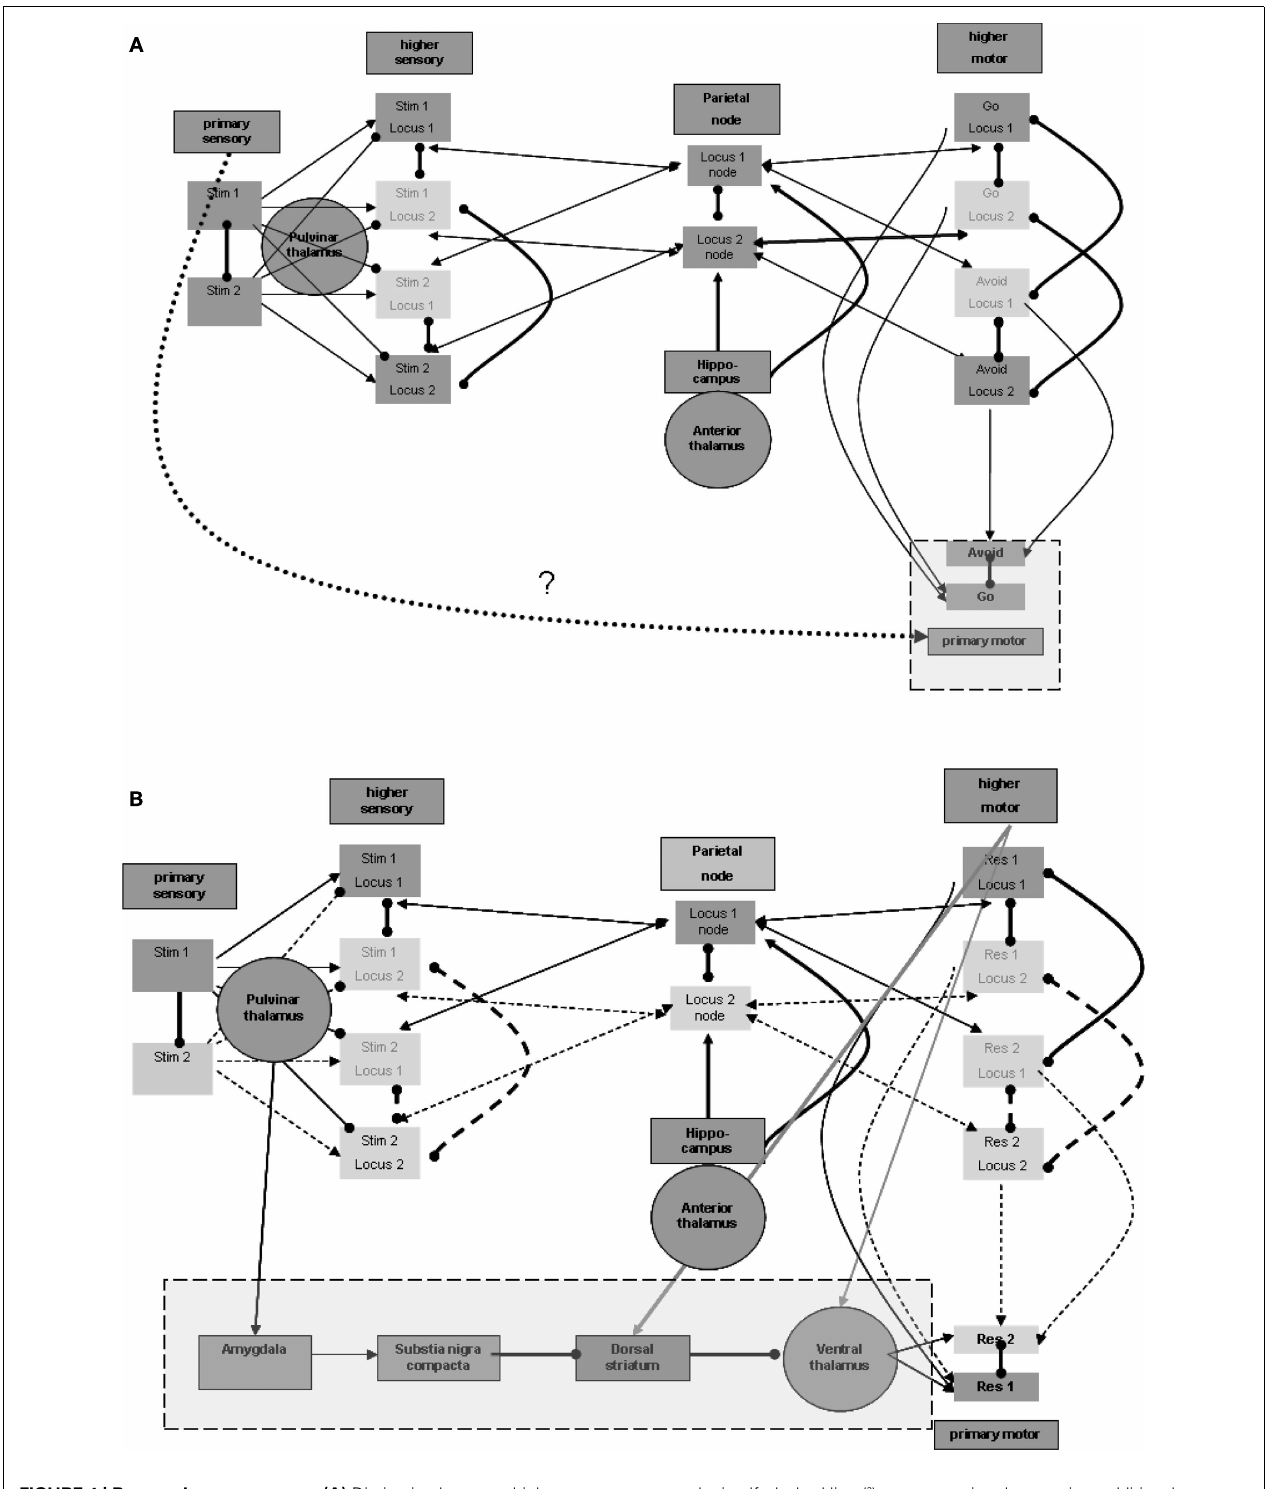
FIGURE 4 | Responsiveness process . (A) Distinction between higher and primary motor regions. (B) Plausible regions participating in promoting responsiveness. Note that connection strengths are depicted as follows: solid line (—) a connection that can take effect on